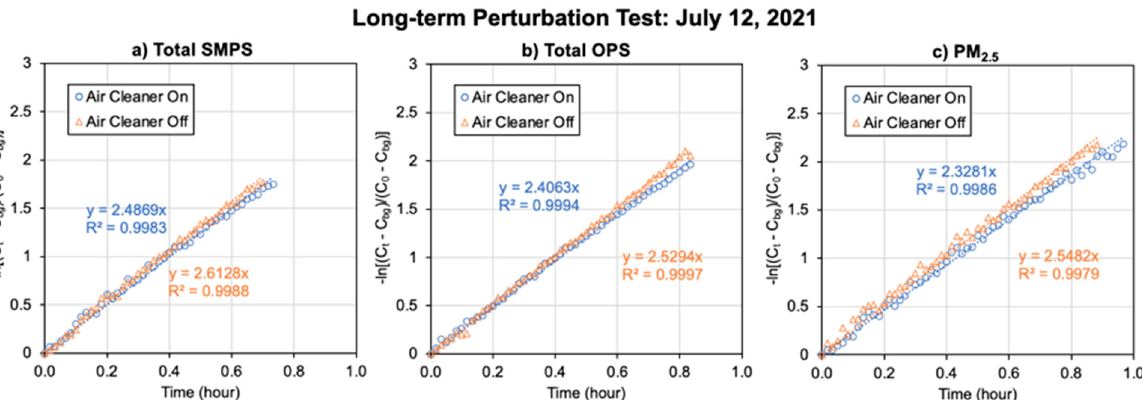
Figure 9. First-order particle loss rate constants ( λ + k ) from a short-term perturbation test (7 July 2021) after the air cleaner operated for a few hours and after the air cleaner was switched off: ( a ) total number concentrations measured by the SMPS (0.01–0.4 µm), ( b ) total number concentrations measured by the OPS (0.3–10 µm), and ( c ) estimated PM 2.5 mass concentrations.